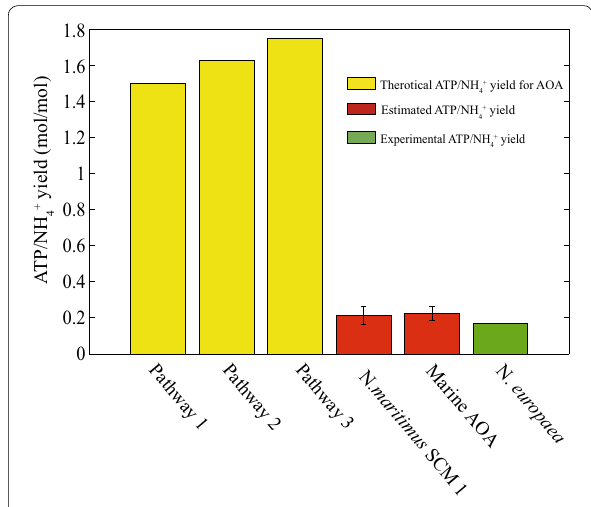
Fig. 6 Comparison of theoretical and estimated ATP/NH 4 + yield based on Table